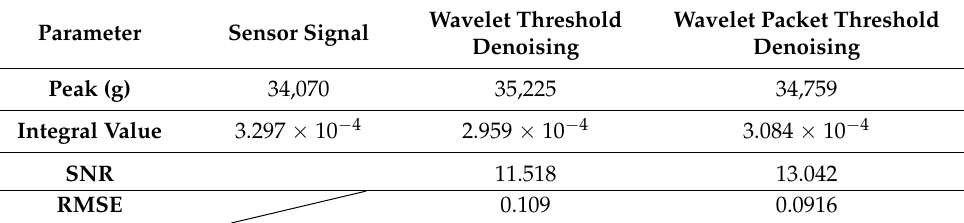
Table 3. Summary of the denoising performance of the two